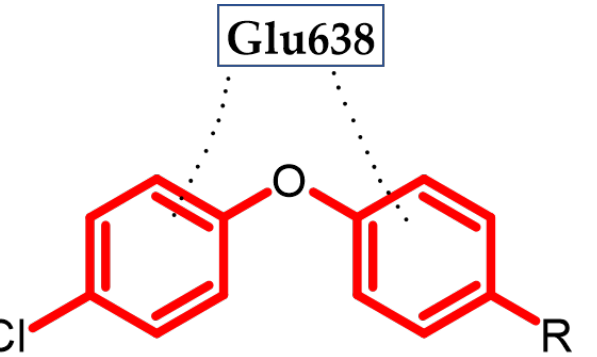
Figure 15. Schematic representation of H- π interactions (black dots) formed by a phenoxyphenyl moiety with STAT3 (R is the rest of the compound structure).